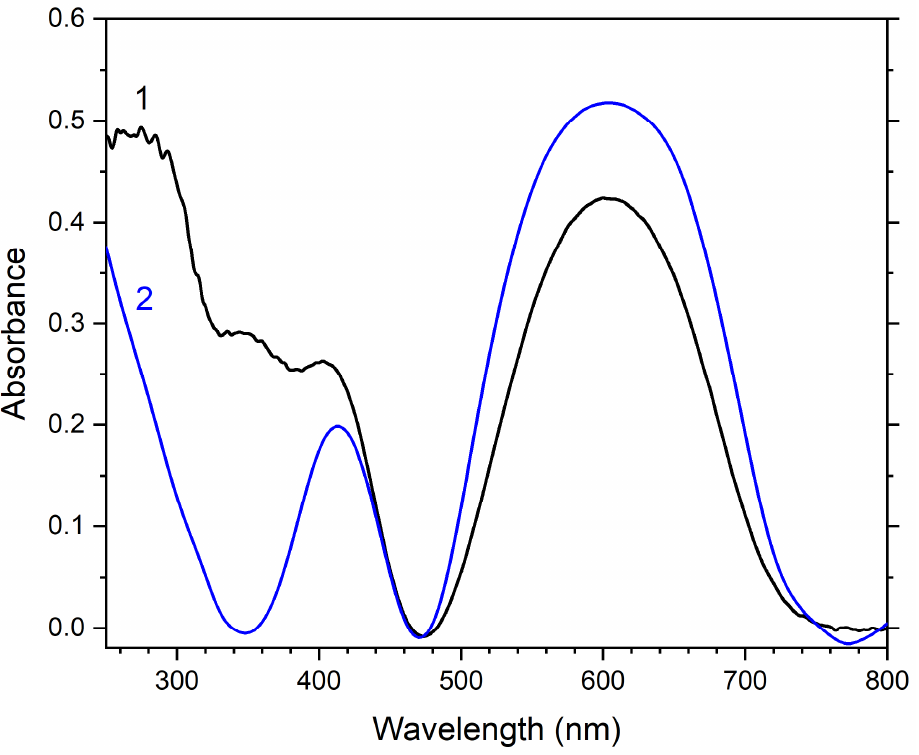
Figure 14. Diffuse absorption spectra of original haüyne (Sample 4) (1) and Sample 4 heated at 800 ◦ C (2).